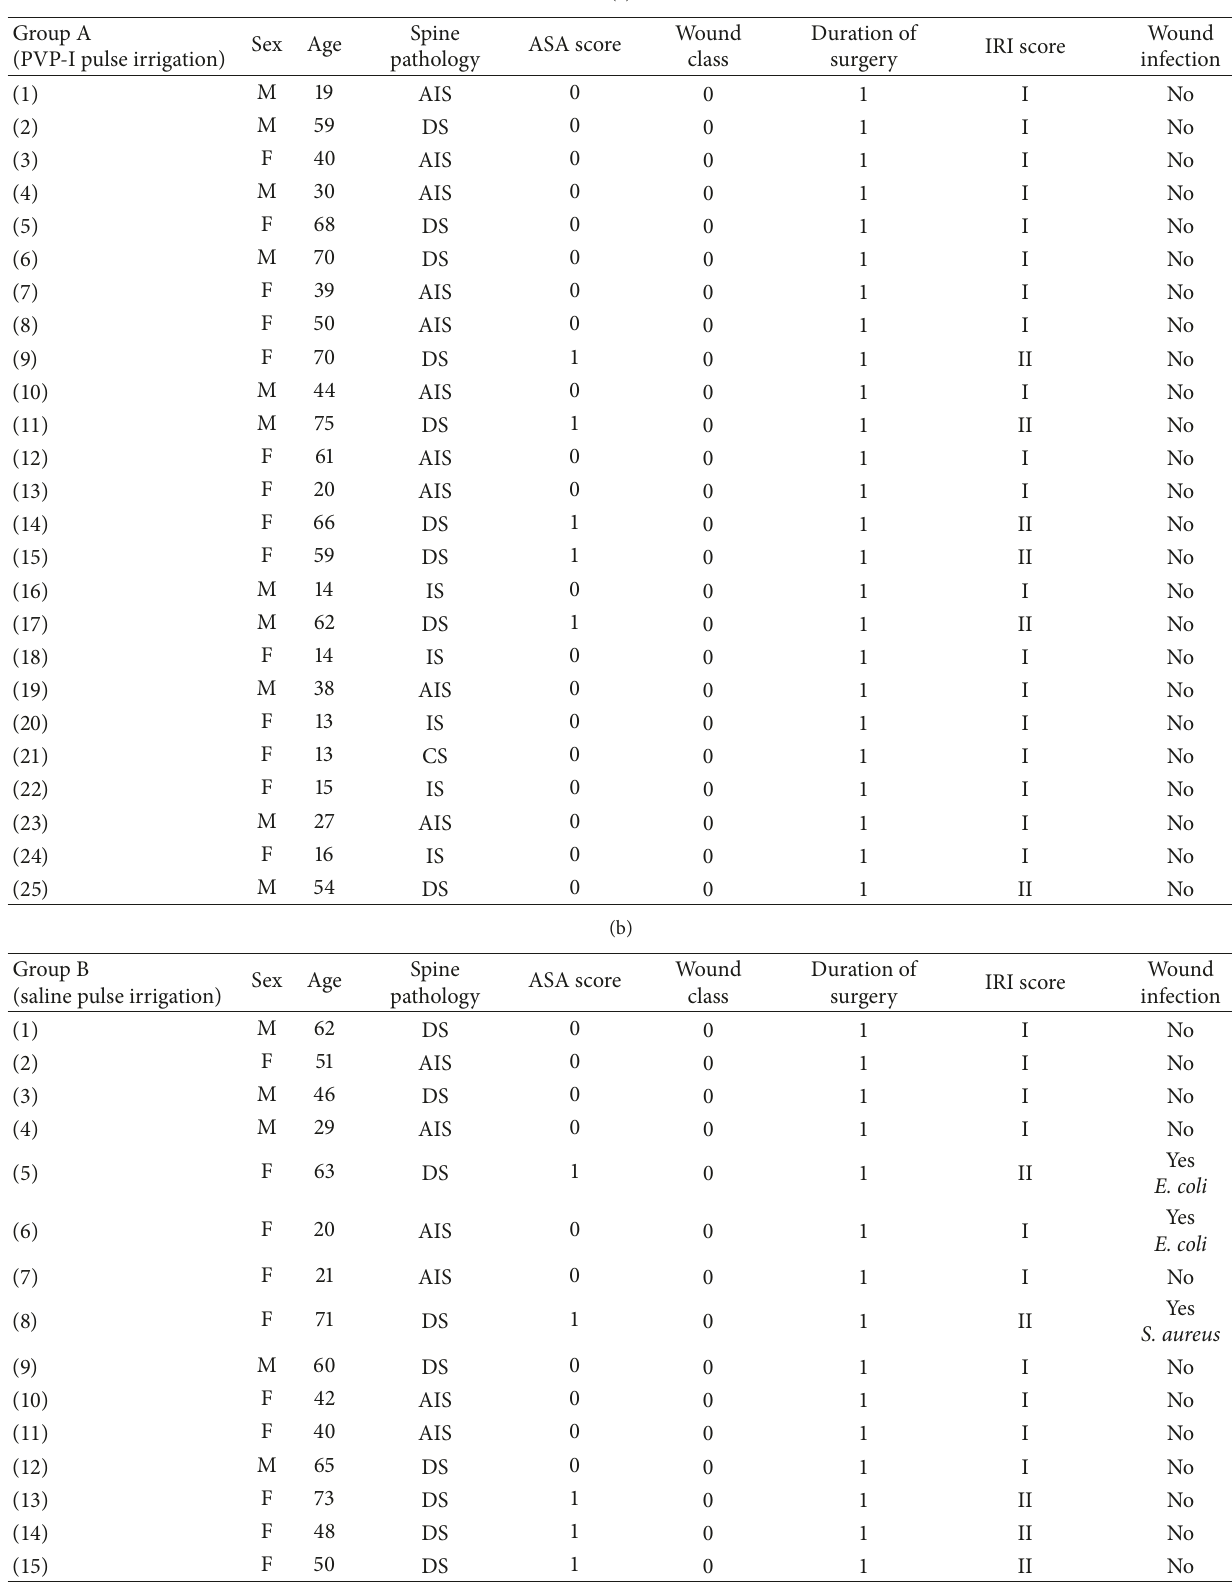
Table 2: List of two-subgroup patients’ age, sex, spine pathology, kind of treatment, IRI score, ASA, duration of surgery, wound class, and wound infection.